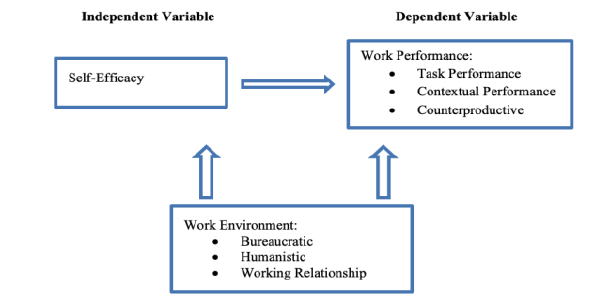
Figure 1: The framework reflects the correlation between self-efficacy and work performance as mediated by the work environment; Source: Schwarzer, R., & Jerusalem, M. (1995), Abun, et.al (2021) and Koopmans, et.al